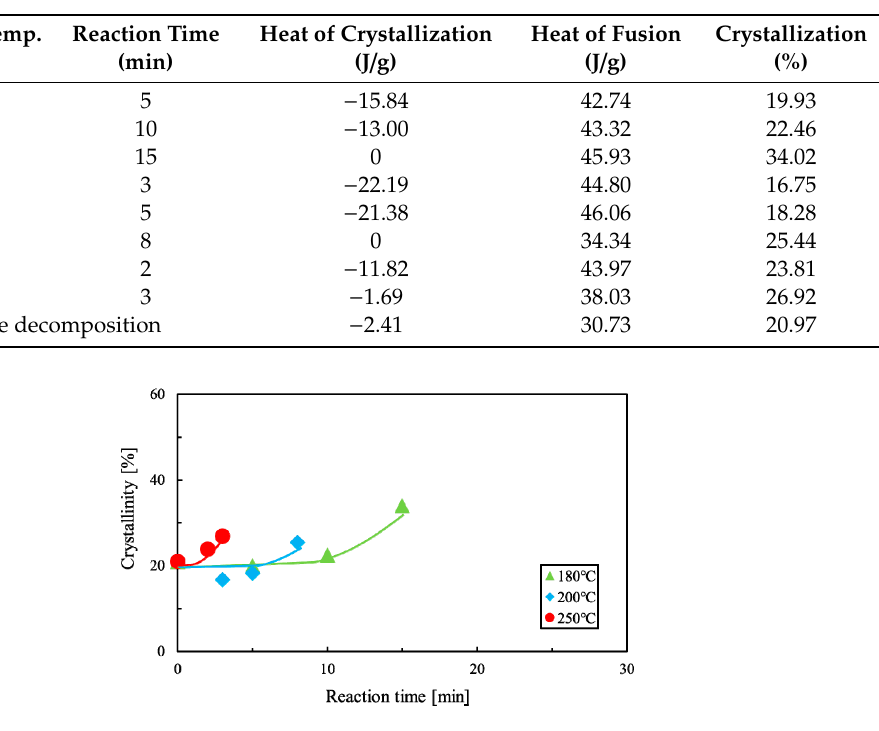
Figure 5. Dependences of reaction temperature and time of crystallinity of polylactic acid (PLA) after sub-critical water decomposition. sub-critical water decomposition.